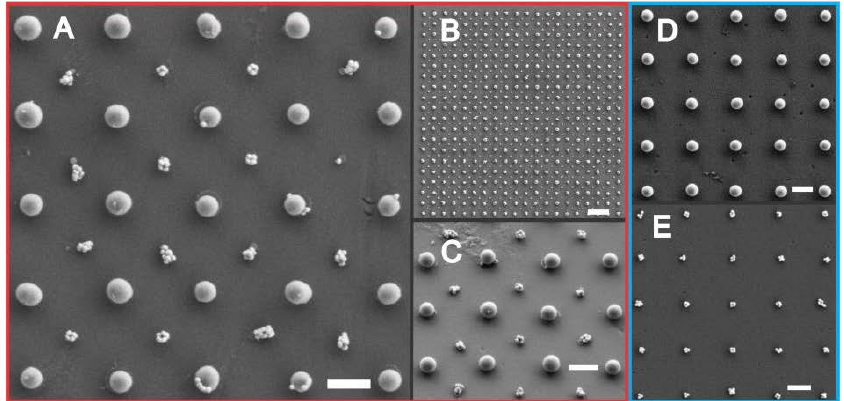
Figure 7: SEM images of the extended optoplasmonic arrays containing 250 nm TiO 2 nanoparticles and 60 nm Au nanoparticles. (A) – (C) Complete optoplasmonic hybrid arrays at different magnifications. (D) TiO 2 nanoparticle array. (E) Au nanoparticle cluster array. Scale bars are 500 nm in (A), (C) – (E), and 2 µ m in (B). The grating period is set for all arrays, Λ = 1000 nm. Reprinted with permission from Hong et al.